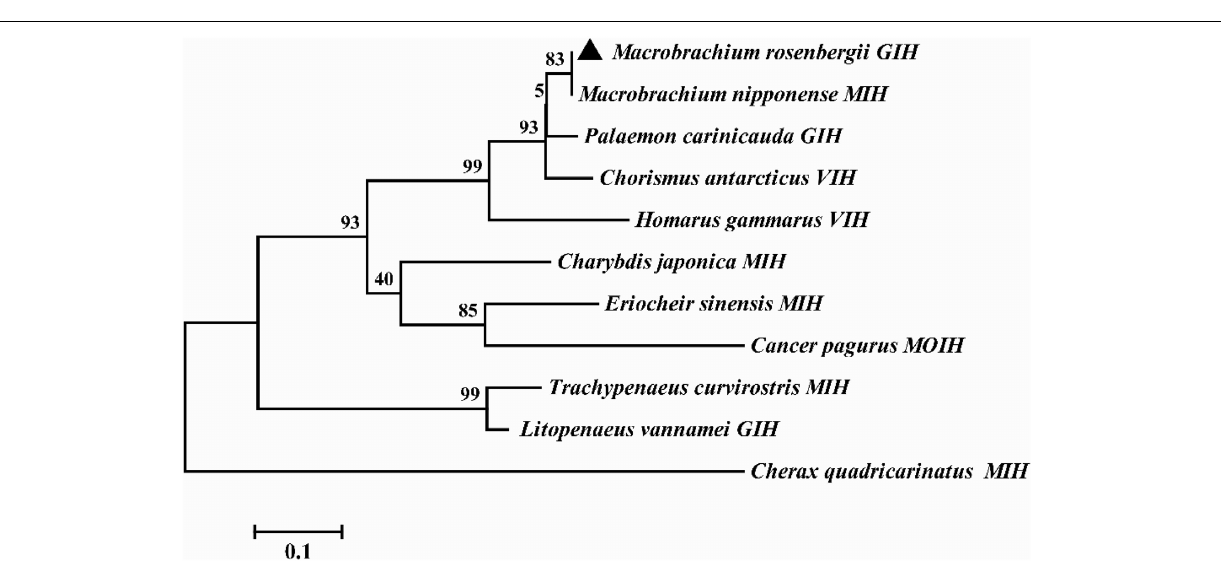
Frontiers in Marine Science |